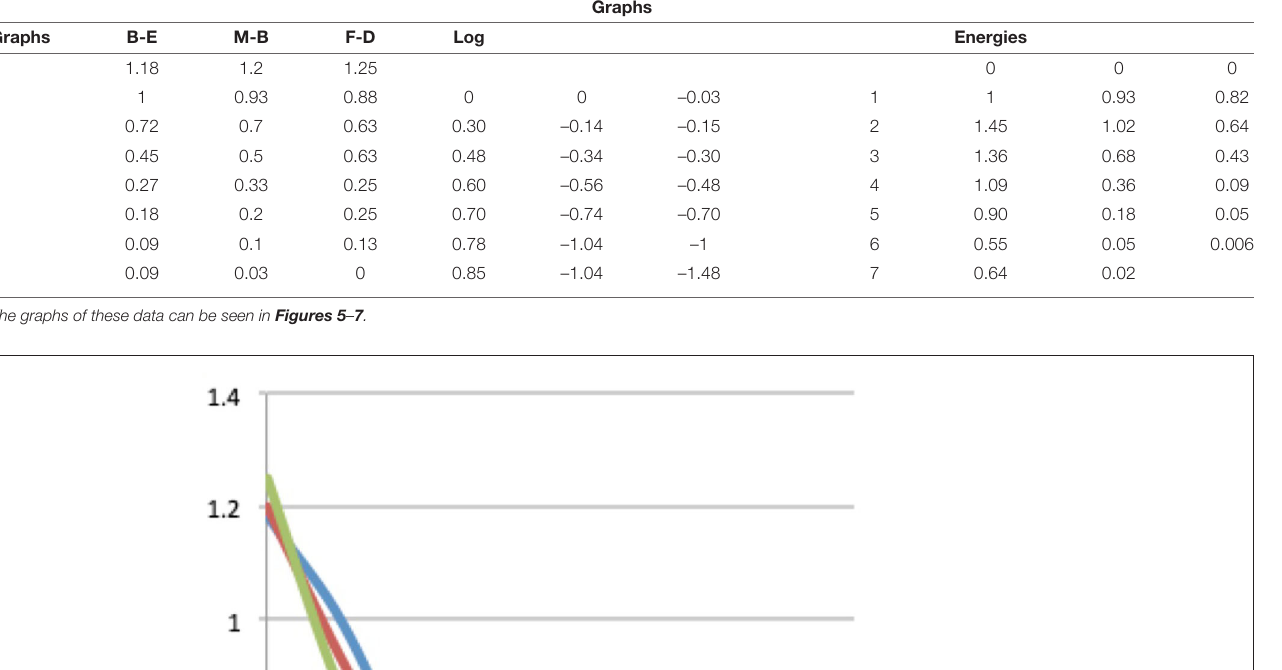
graph, the Maxwell-Boltzmann, in an opposite way. This is no coincidence and is connected to the “meaning dynamics” that we now wish to discuss and